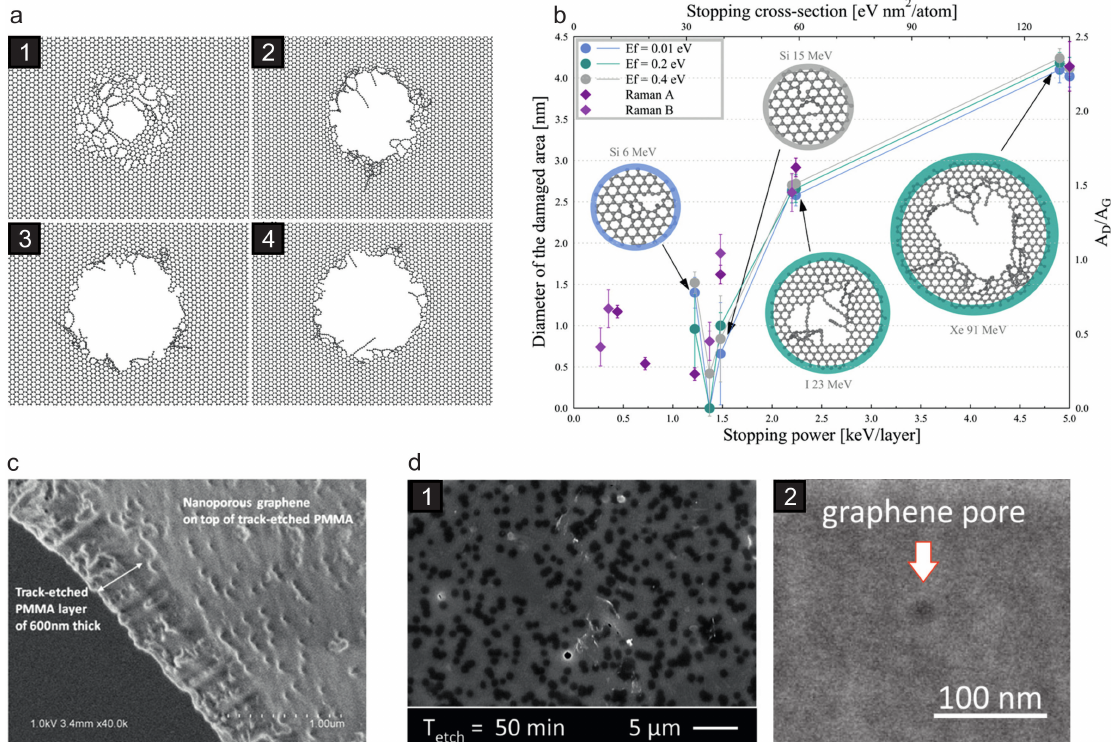
Figure 9. Pore creation in supported and suspended graphene by SHI irradiation. ( a,b ) MD simulations of SHI irradiation of graphene. ( a ) Results for graphene on a SiO 2 substrate. Large pores can be created by individual impacts, the size of which can be controlled via the electronic stopping of the projectile. Data is shown for dE el / dx values of ( 1 ) 6.5 keV/nm, ( 2 ) 8 keV/nm, ( 3 ) 10 keV/nm, ( 4 ) 12 keV/nm. Only graphene is shown for clarity. Reprinted from from Ref. [117], Copyright (2015), with permission from Elsevier. ( b ) Results for graphene without substrate. Again, the pore size increases with increasing electronic stopping. Reprinted from Ref. [124], Copyright (2017), with permission from Elsevier. ( c,d ) Scanning electron microscope images from graphene/polymer membranes which have been irradiated with SHI and subsequently etched. Composite membranes with nanometer-sized pores in the graphene can be obtained in this way. ( c ) Reprinted from from Ref. [126], Copyright (2016), with permission from Elsevier; ( d ) Reproduced from Ref. [127] with permission from The Royal Society of